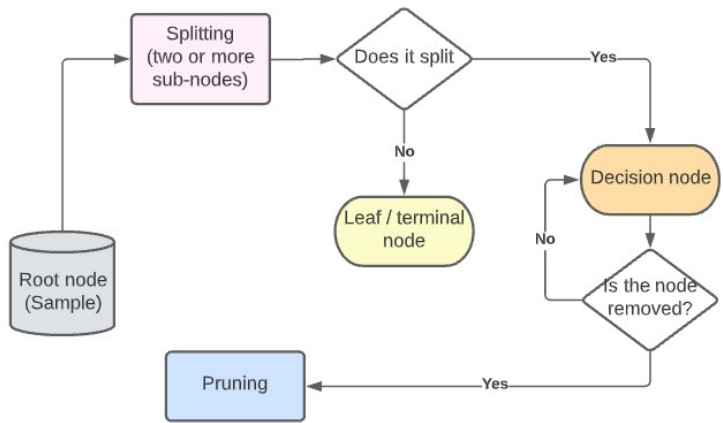
Figure 6. Decision Tree flowchart .